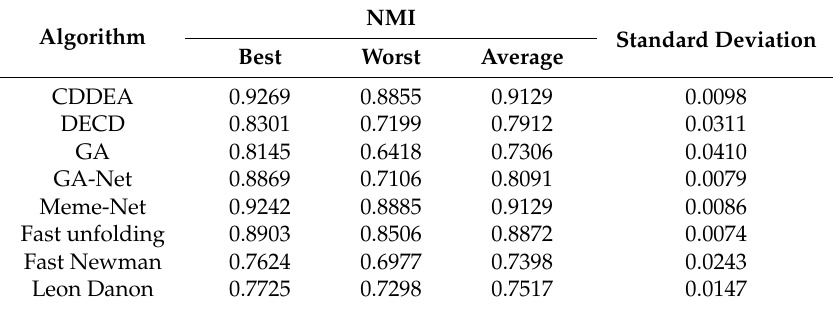
Table 4. NMI result obtained using eight algorithms on the American college football